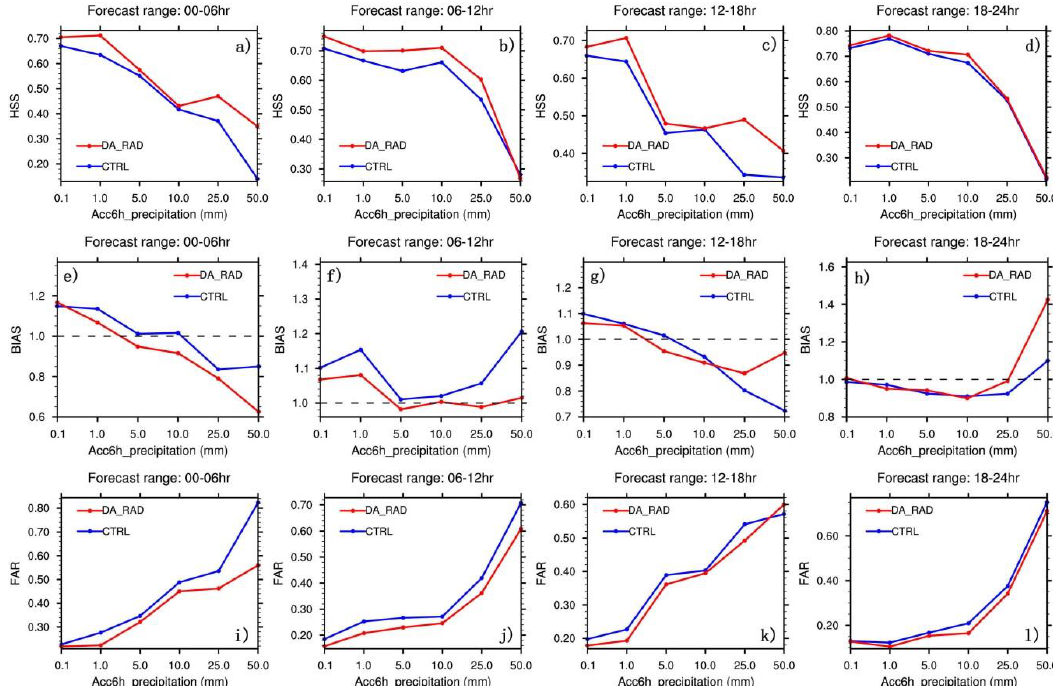
Figure 9. Statistical indices of the Heidke skill score (HSS) ( a–d ), bias score (BIAS) ( e–h ), and false alarm rate (FAR) ( i–l ) for 6-h accumulated rainfall from the forecasts before (CTRL) and after (DA_RAD) assimilating ATMS radiance data.